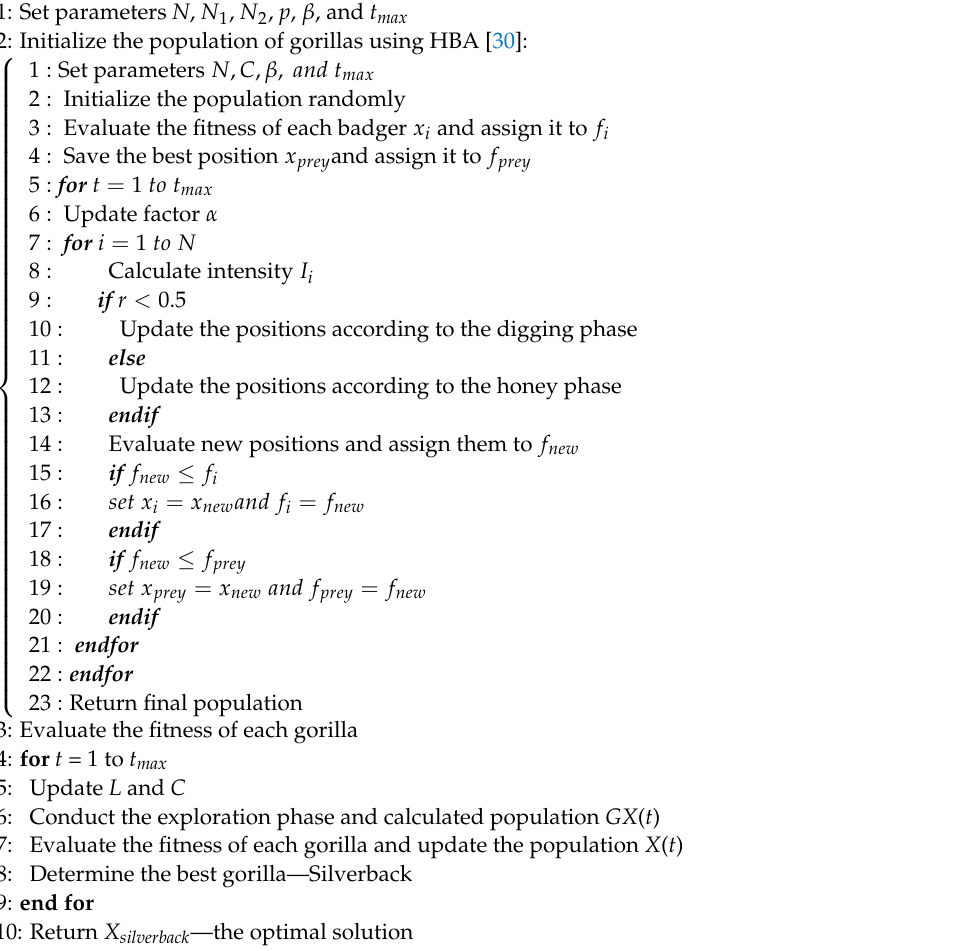
Algorithm 2: Complete pseudo-code of the honey badger algorithm and artificial gorilla